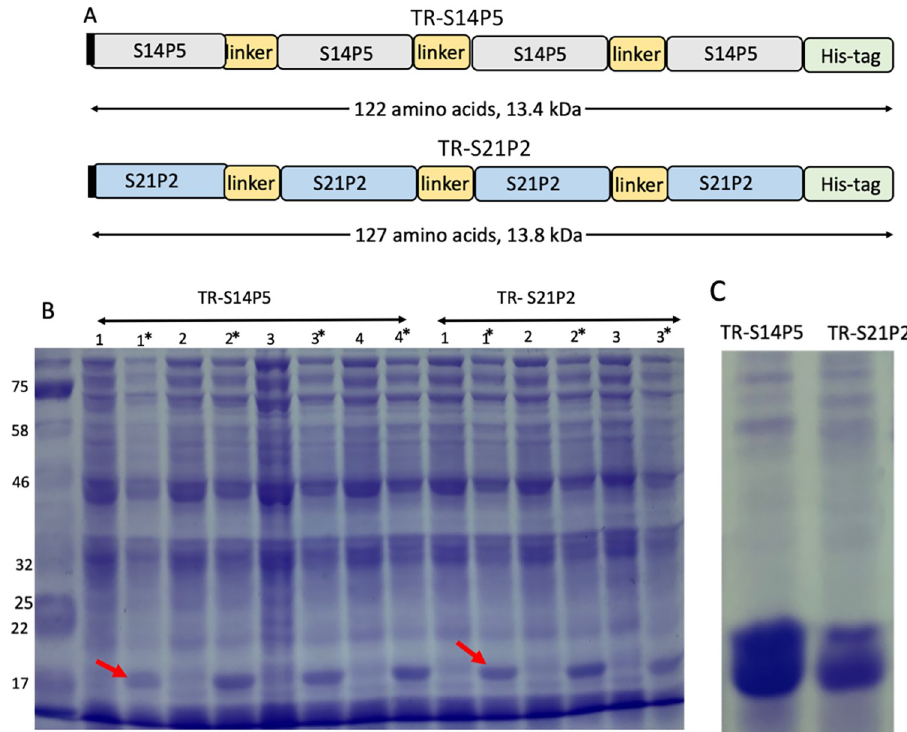
Fig 1. Expression of repeat linear epitope S14P5 and S21P2 in E . coli . (A): Schematic diagram of repeat linear epitope S14P5 and S21P2. (B): Protein profiles of transformed E . coli before and after ( � ) IPTG induction. Arrows